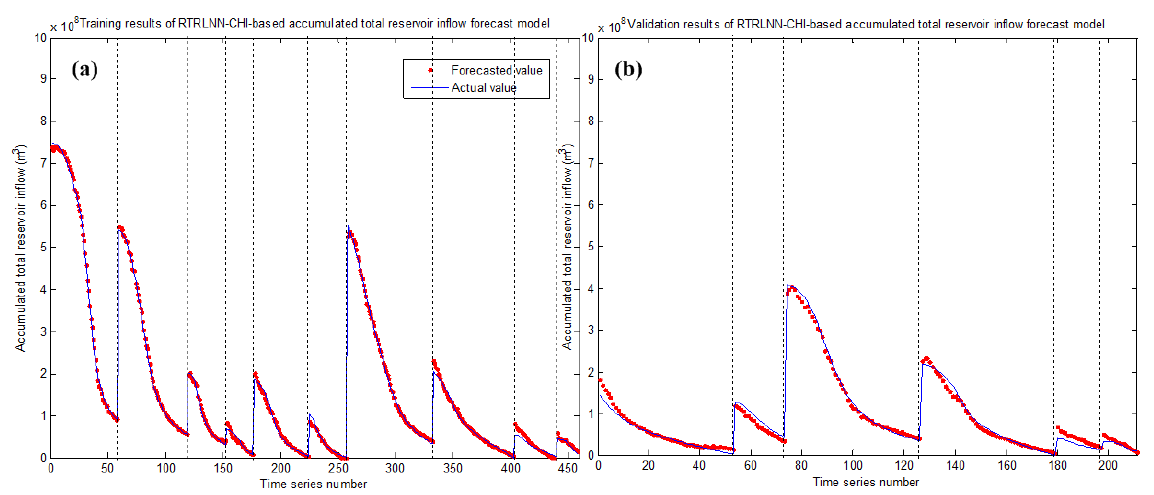
Figure 10. Training and validation results of RTRLNN-CHI-based accumulated total reservoir inflow forecast model: ( a ) training stage; ( b ) validation